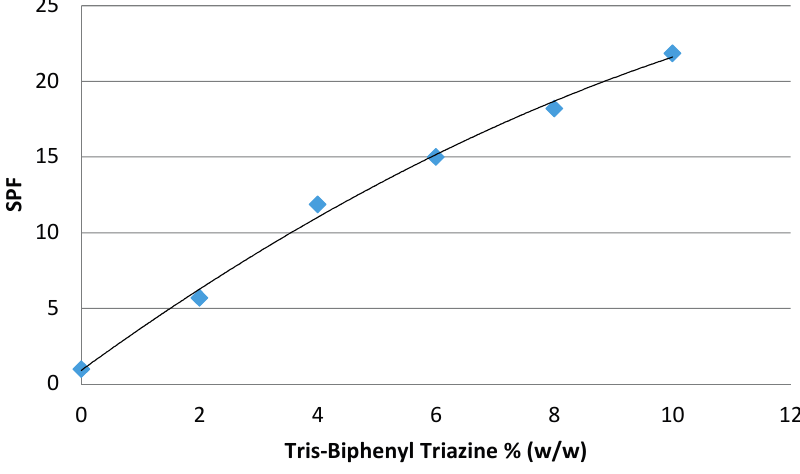
Figure 3. Efficacy of Tris-Biphenyl Triazine in UVA range.